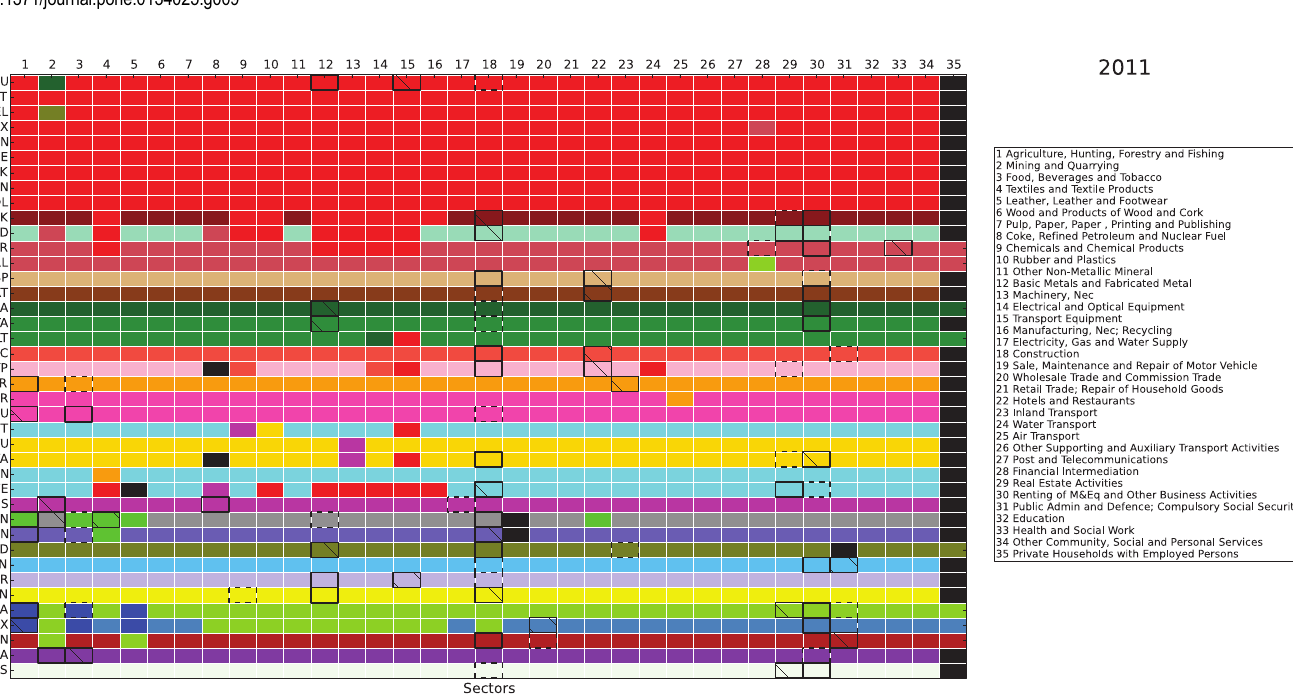
PLOS ONE | DOI:10.1371/journal.pone.0134025 July 29,